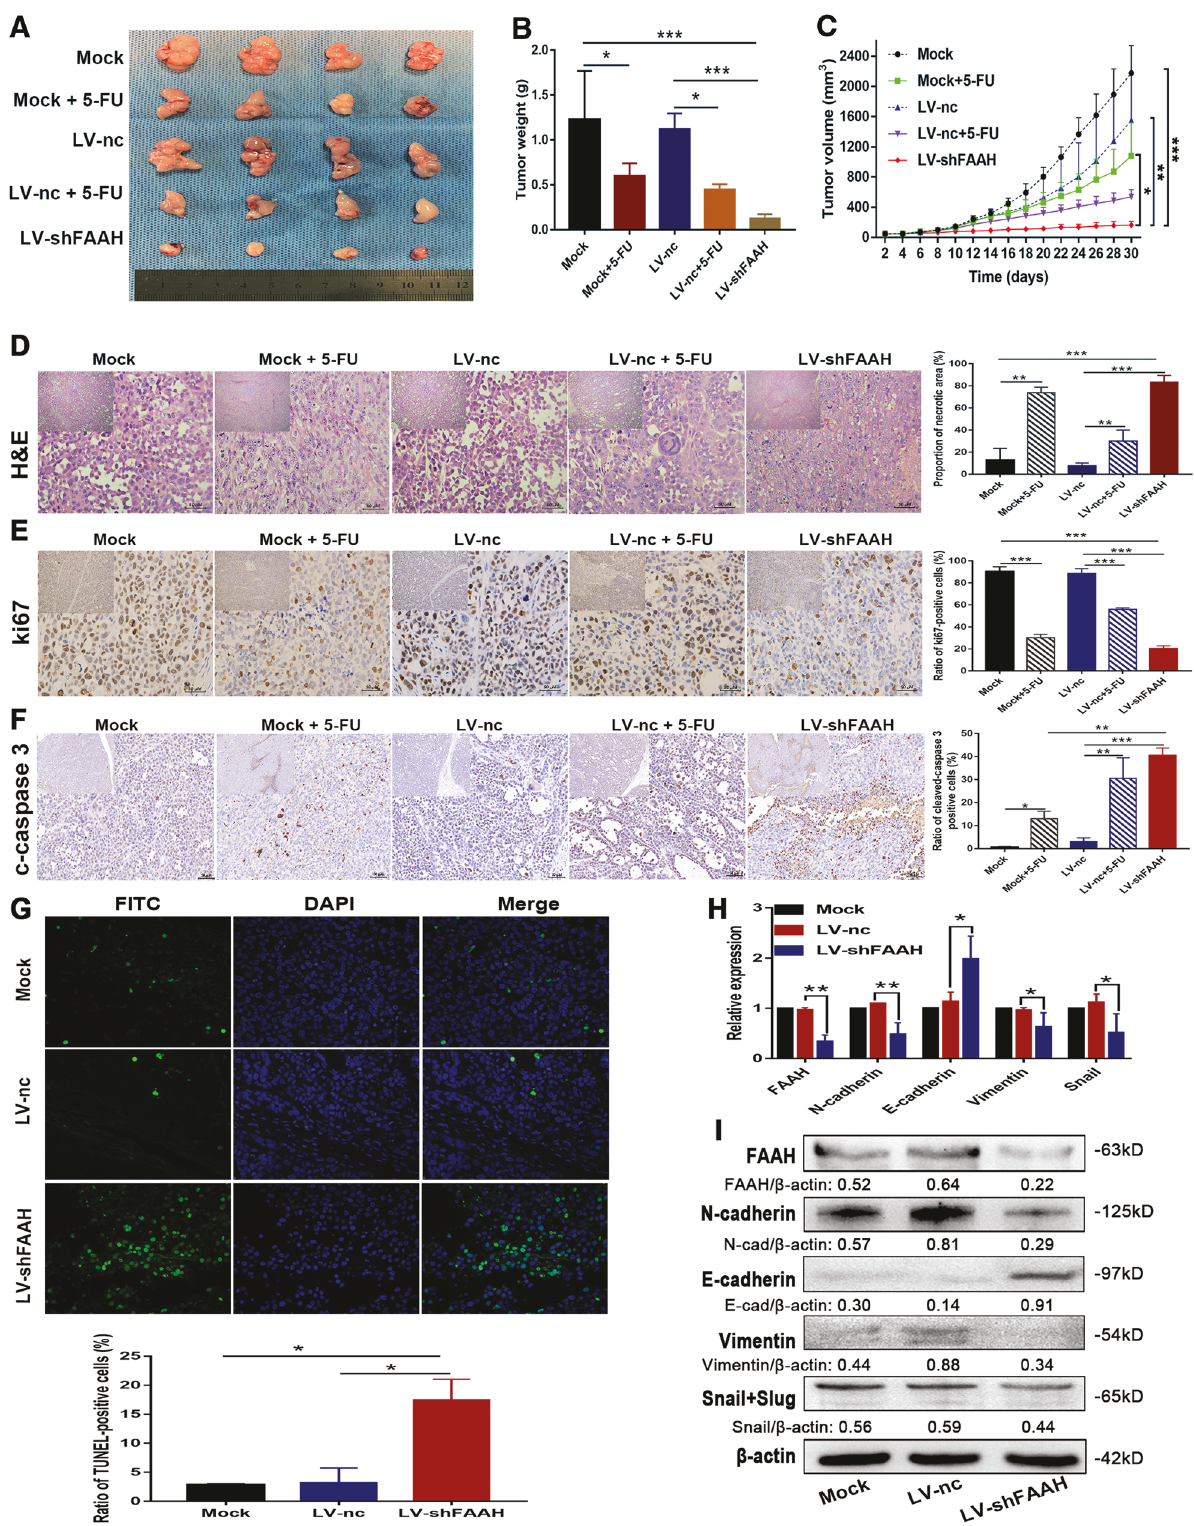
Fig. 3 FAAH depression inhibits tumour growth and metastasis in vivo. A Tumour specimens photographed with a high-de fi nition digital camera. B Weight of exfoliated tumours was measured by a tray balance. C Tumour growth curve was plotted by measuring the tumour volume every 2 days. D H&E staining of exfoliated tumour tissues (magni fi cation: upper left corner, ×100; whole, ×400); IHC staining of tumour tissues with ( E ) anti-ki67 and ( F ) anti-cleaved caspase 3 antibody (magni fi cation: upper left corner, ×100; whole, ×400). G Apoptotic cells of xenografts detected by TUNEL (magni fi cation: ×400). Detection of EMT markers in tumour tissues by ( H ) qRT-PCR and ( I ) western blotting. * p < 0.05, ** p < 0.01, *** p < 0.001. c-caspase 3 cleaved caspase 3.